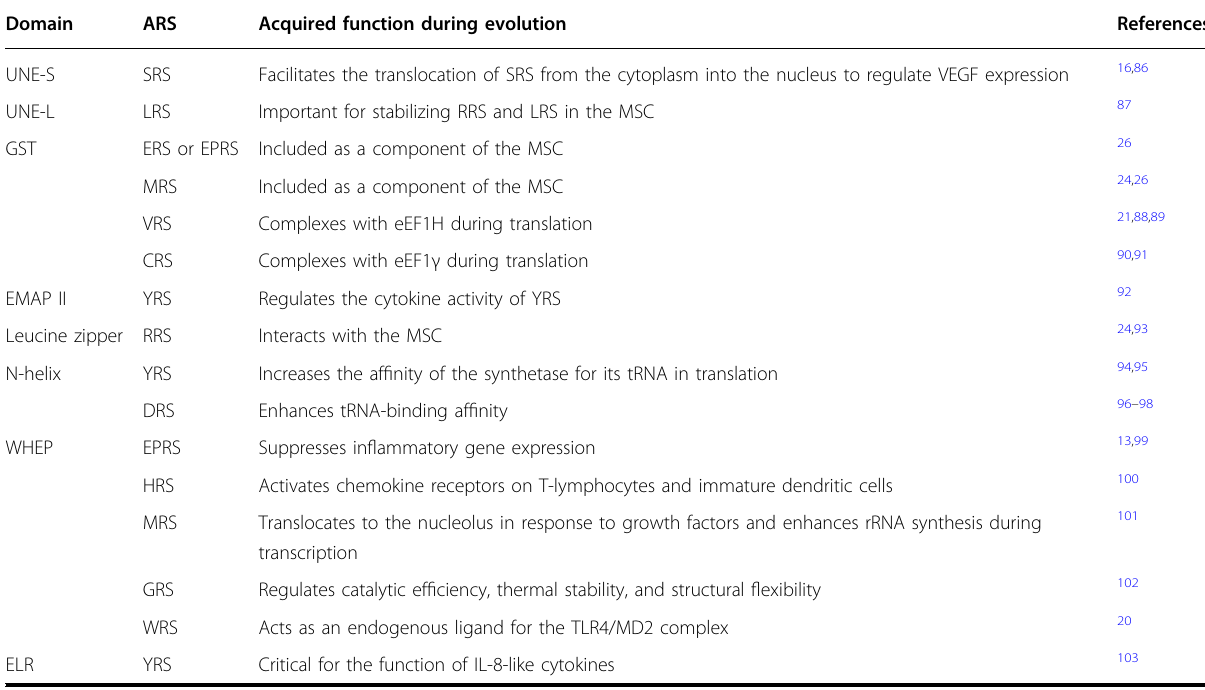
Table 1 Non-canonical functions of the new domains and motifs in selective aminoacyl-tRNA synthetases Domain